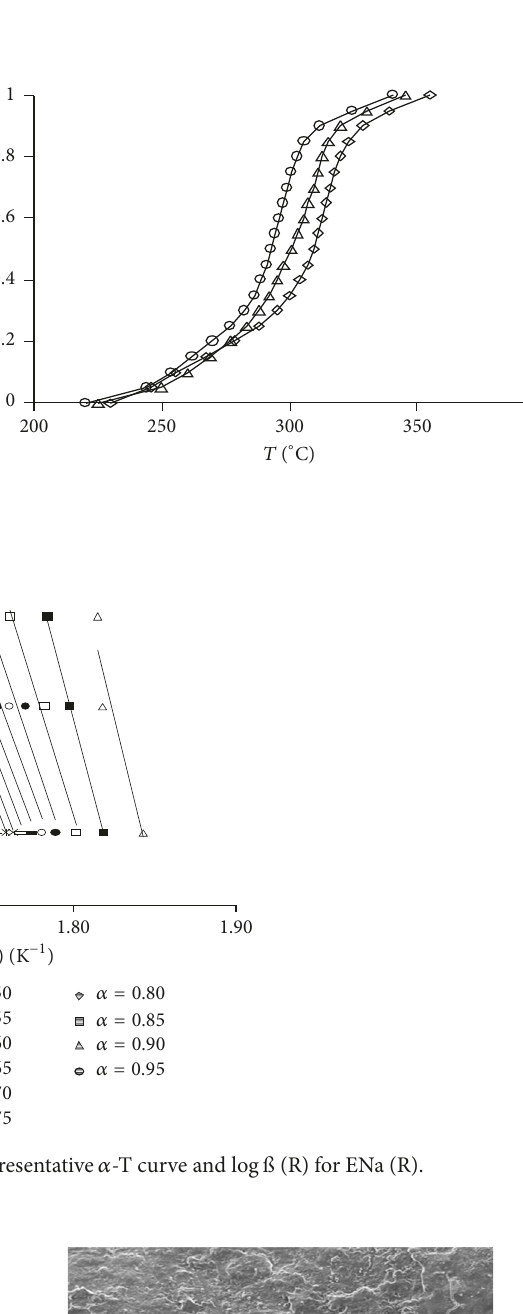
3.2.6. Water Retention Value (WRV). The WRV was found to be 7000% to 7500% to its original volume. The H 2 O holding capacity decreased on exposure to atmosphere with the passage of time; therefore WRV is not permanent.